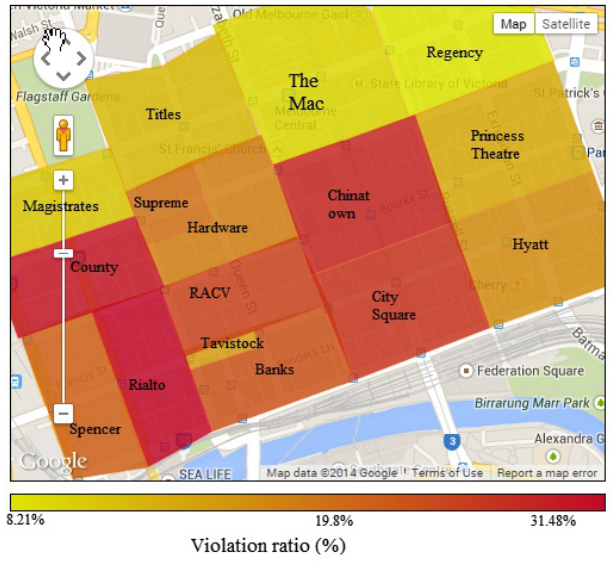
Figure 6. Parking violation ratio by